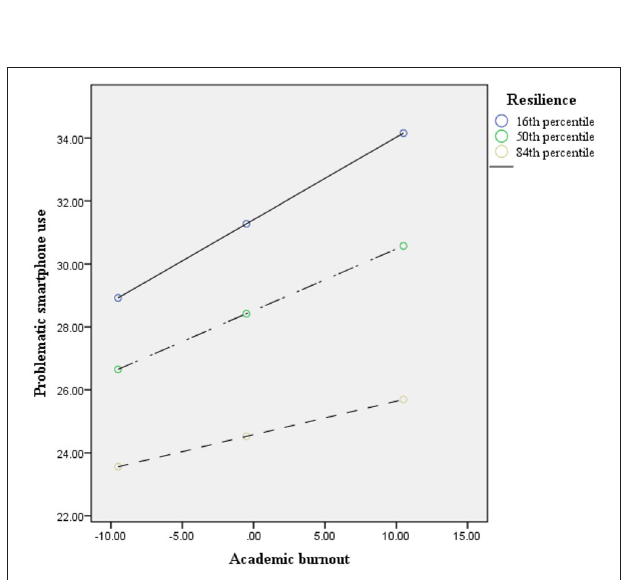
FIGURE 3 | The conditional effect between academic burnout and problematic smartphone use ( N = 748). To further understand the moderation effect of resilience on the path between academic burnout and problematic smartphone use, a conditional indirect effect analysis was conducted at 16th, 50 th , and 84th percentiles resilience.